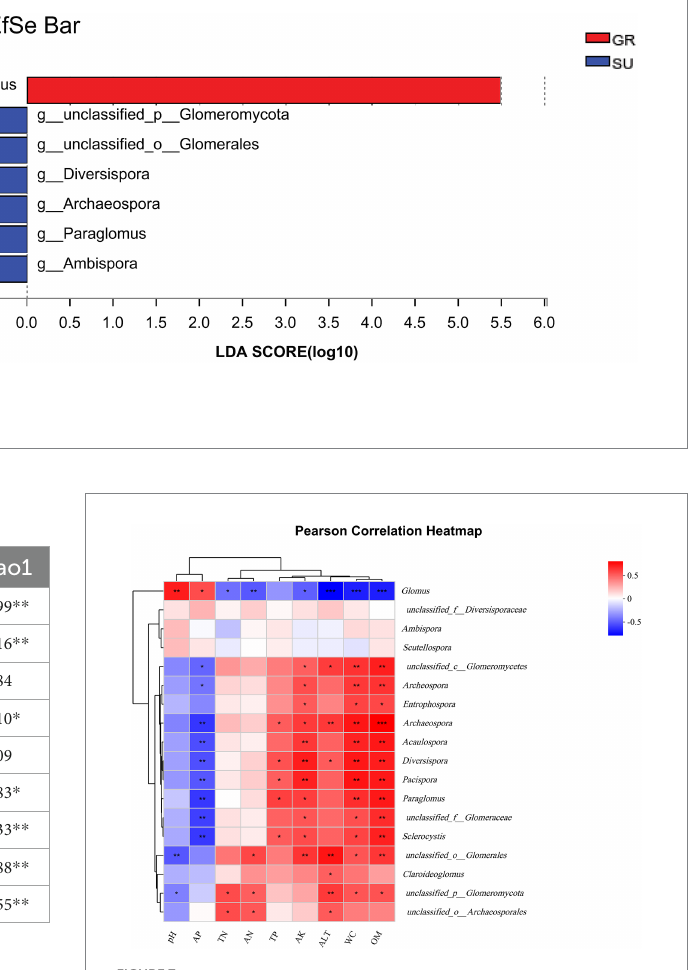
FIGURE 7 Heatmap of Person correlation between AMF community genus level and physico-chemical properties of soil. *represent significant correlations at the 0.05, **represent significant correlations at the 0.01, and ***represent significant correlations at the 0.001.